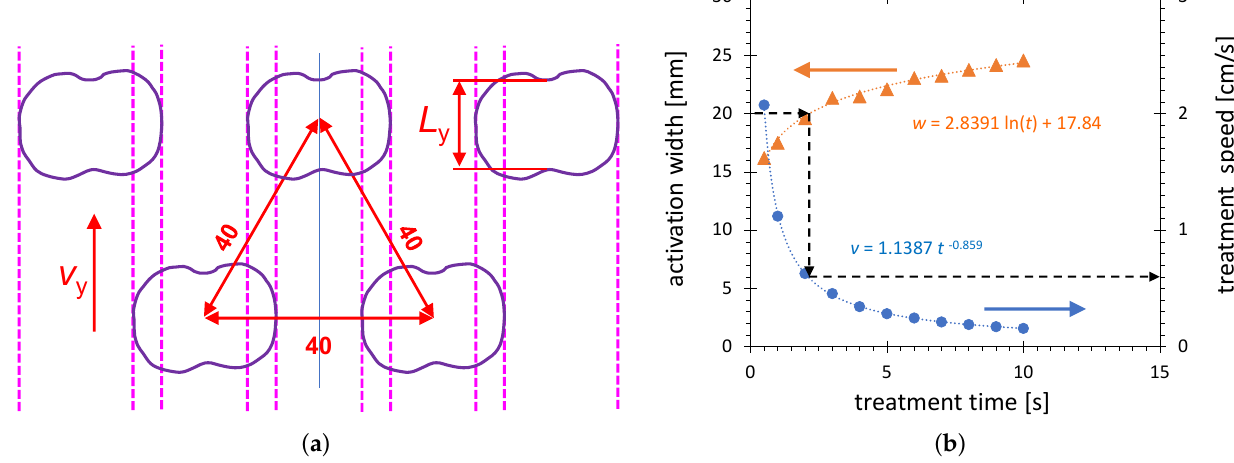
Figure 6. Determination of the CeraPlas™F module array geometry. ( a ) The position of the CeraPlas™F modules fulfilling the conditions of no interference and homogeneous treatment. ( b ) The width of the image of the activation area achieved on a HDPE substrate treated with piezobrush ® PZ3 operated with power of 8 W and the equivalent treatment